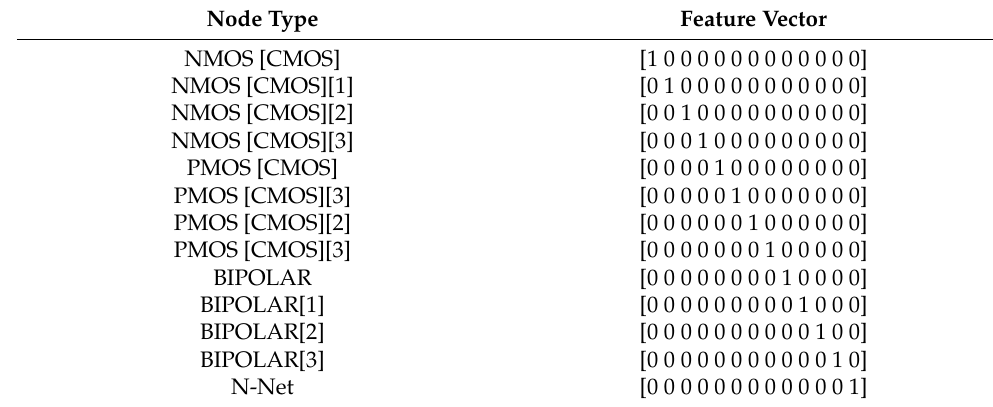
Table 14. Thirteen unique types of elements are considered for Features